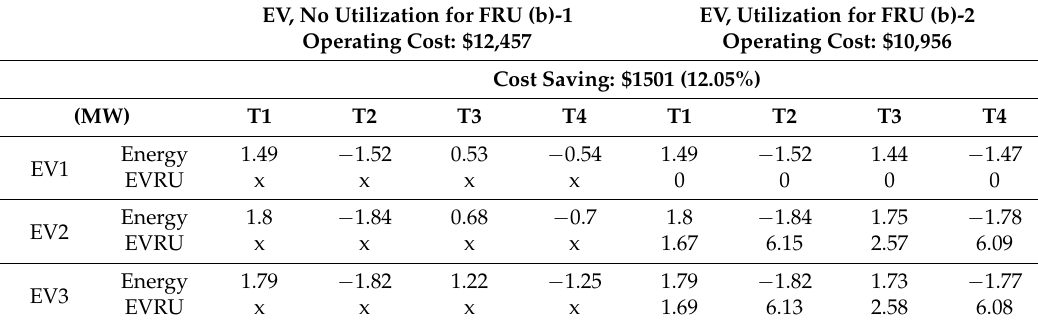
Table 5. EV dispatch results for case (b).